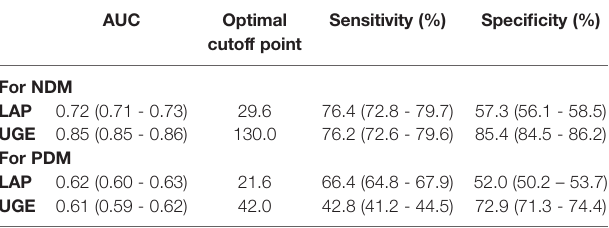
TABLE 2 | Performance of LAP and UGE for predicting NDM and